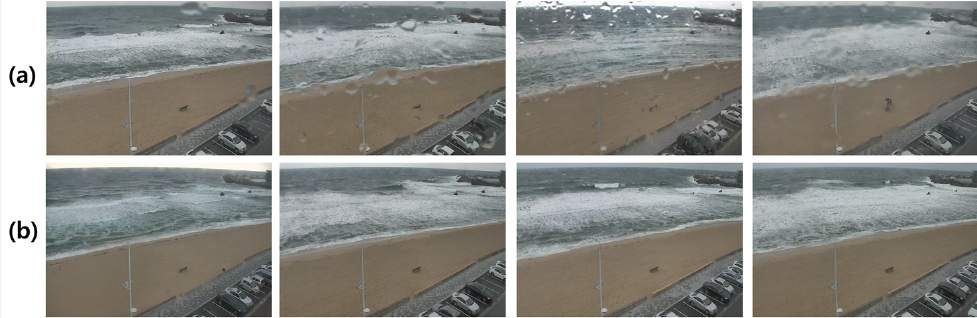
Figure 6. Samples of our Anmok unpaired dataset : ( a ) images degraded by raindrops; and ( b ) clean (raindrop-free) images not corresponding to those in ( a